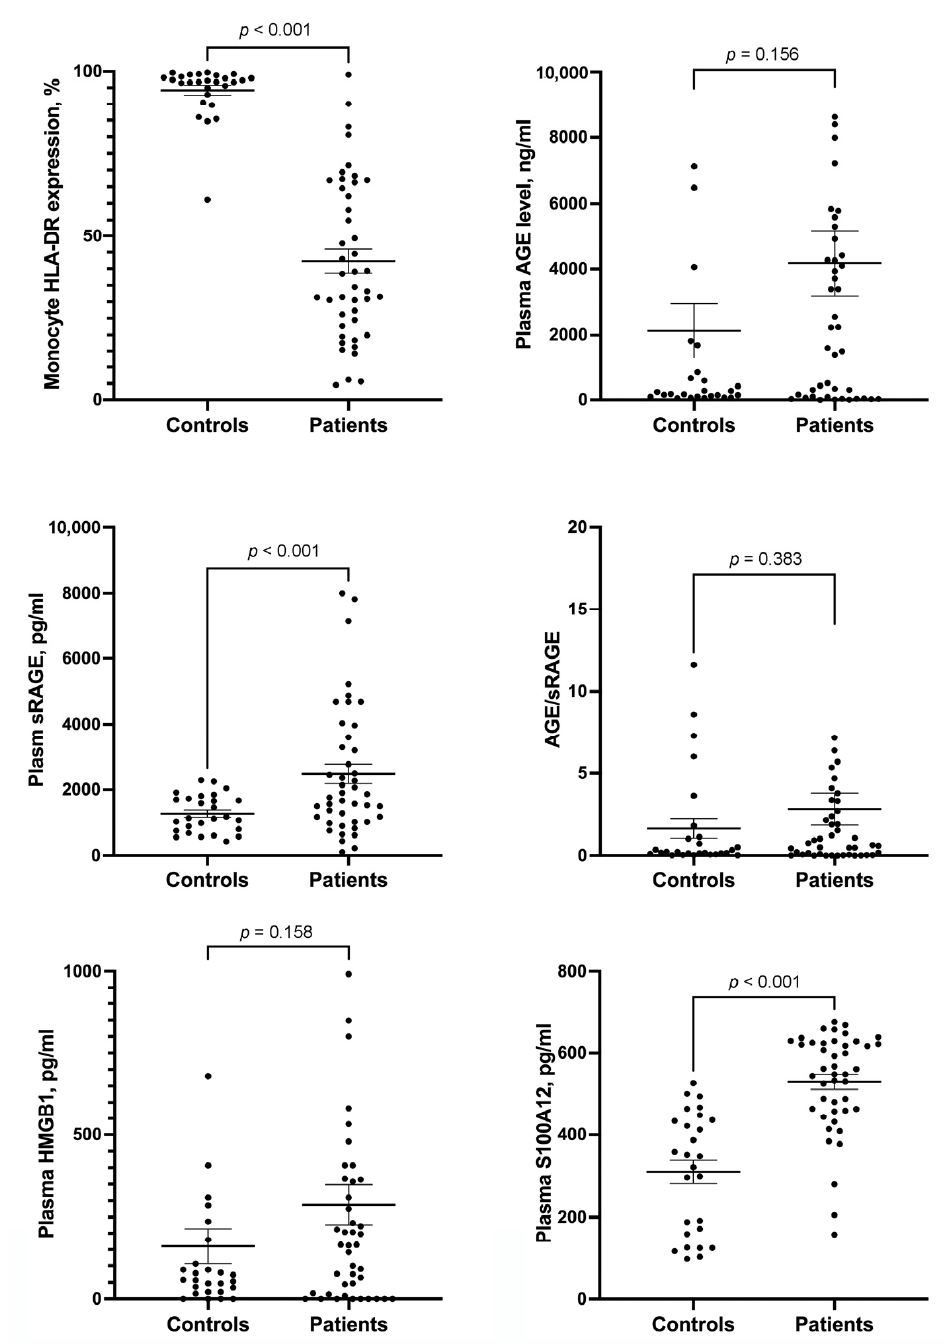
Figure 1. Scatterplots showing the levels of monocyte HLA-DR expression, plasma AGE, plasma sRAGE, AGE/sRAGE ratio, plasma HMGB1, and plasma S100A12 between controls and patients with sepsis. Error bar represents mean and standard error mean. HLA = human leukocyte antigen; AGE = advanced glycation end products; sRAGE = soluble receptor for AGE; HMGB1 = high-mobility group box 1.